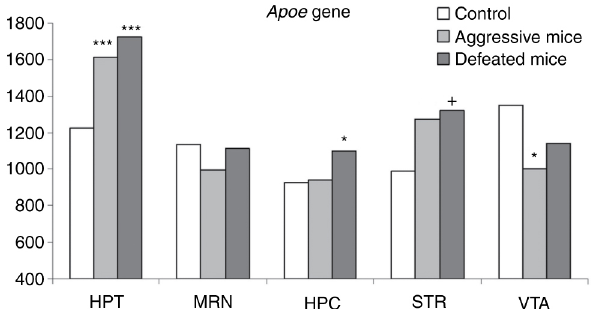
Figure 2: Expression level of ApoE in 5 brain regions of the control, aggressive and defeated mice. Hypothalamus ApoE expression rate is elevated up to 30 % in affected mice compared to controls and exceeds the average across the regions. HPC, hippocampus; HPT, hypothalamus; STR, striatum; MRN, midbrain raphe nuclei; VTA, ventral tegmental area.